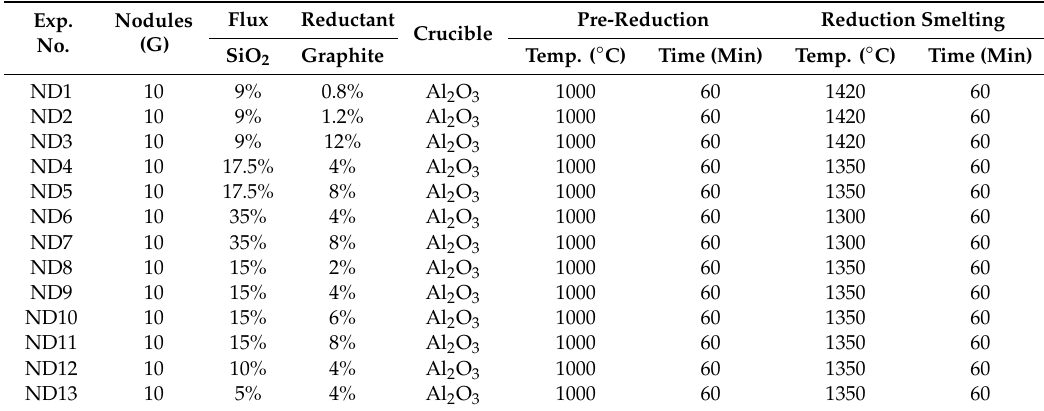
Table 3. Experimental conditions for nodule